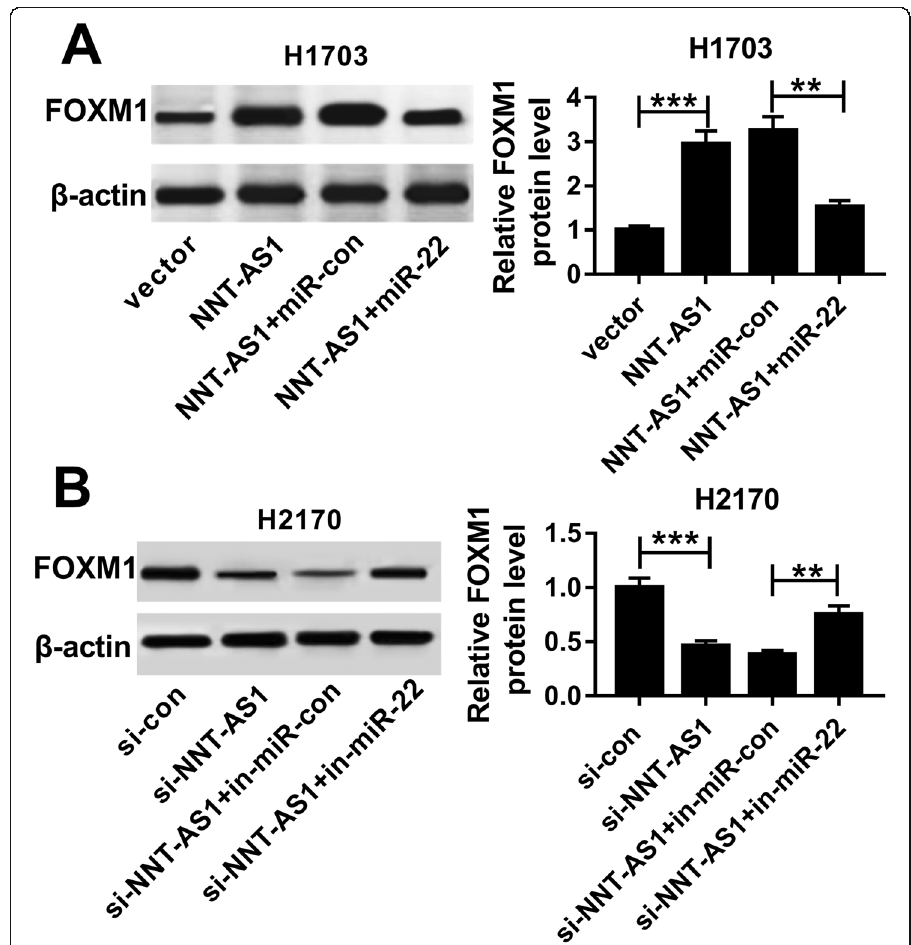
Fig. 6 NNT-AS1 indirectly regulates FOXM1 expression by sponging miR-22 in LUSC cells. a Expression of FOXM1 was examined using western blot in H1703 cells transfected with vector, NNT-AS1, NNT-AS1 + miR- con, or NNT-AS1 + miR-22. b Expression of FOXM1 was determined by western blot in H2170 cells transfected with si-con, si-NNT-AS1, si-NNT-AS1 + in-miR-con, or si-NNT-AS1 + in-miR-22. * P < 0.05, ** P < 0.01, *** P <